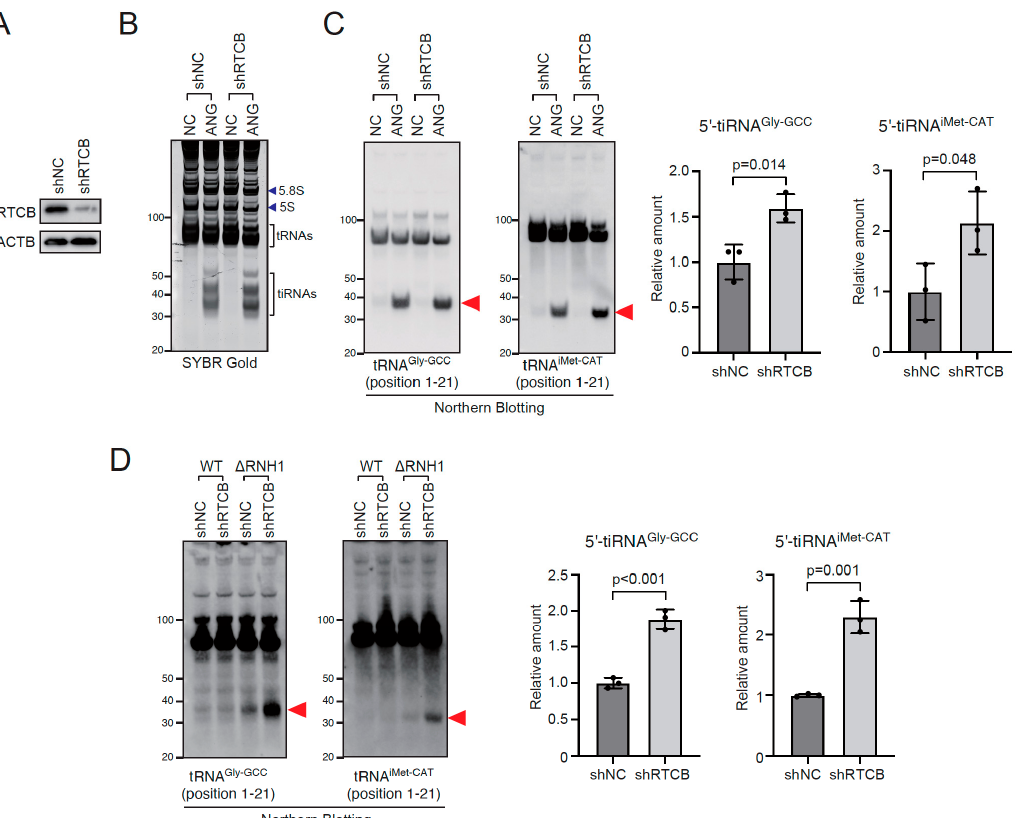
Figure 1. RTCB ligase complex negatively regulates tiRNA production. ( A ) shRNA-mediated knockdown of RTCB. ( B , C ) RTCB knockdown enhances ANG-mediated tiRNA production. U2OS cells were incubated with 0.5 µg/mL ANG for 2 h. ( B ) SYBR Gold staining and ( C ) Northern blotting for tRNA Gly-GCC and tRNA iMet-CAT . Relative amounts of 5 ′ -tiRNAs calculated by densitometry are also shown (n = 3 each). ( D ) RTCB knockdown boosts constitutively generated tiRNAs in RNH1 knockout cells. Northern blotting for tRNA Gly-GCC and tRNA iMet-CAT , and relative amounts of 5 ′ -tiRNAs are shown (n = 3 each). Red arrowheads indicate tiRNAs.